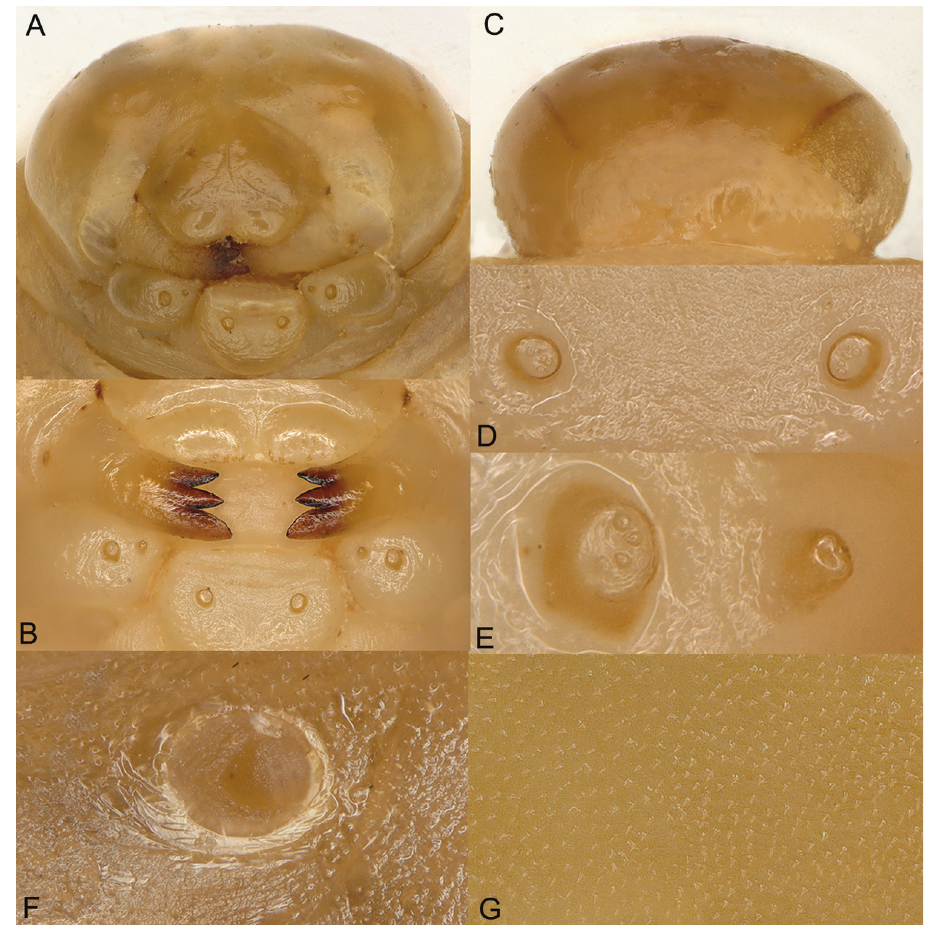
Figure 8. Vespula structor (Smith), mature larvae. A Head, anterior view B part of mouth parts, show- ing maxillary palp, galea, labial palpi and spinneret C head, dorsal view D labial palpi with four apical sensilla E maxillary palp with four apical sensilla (sometimes three) F spiracle G cuticle integument with scattered, short setae and dense minute